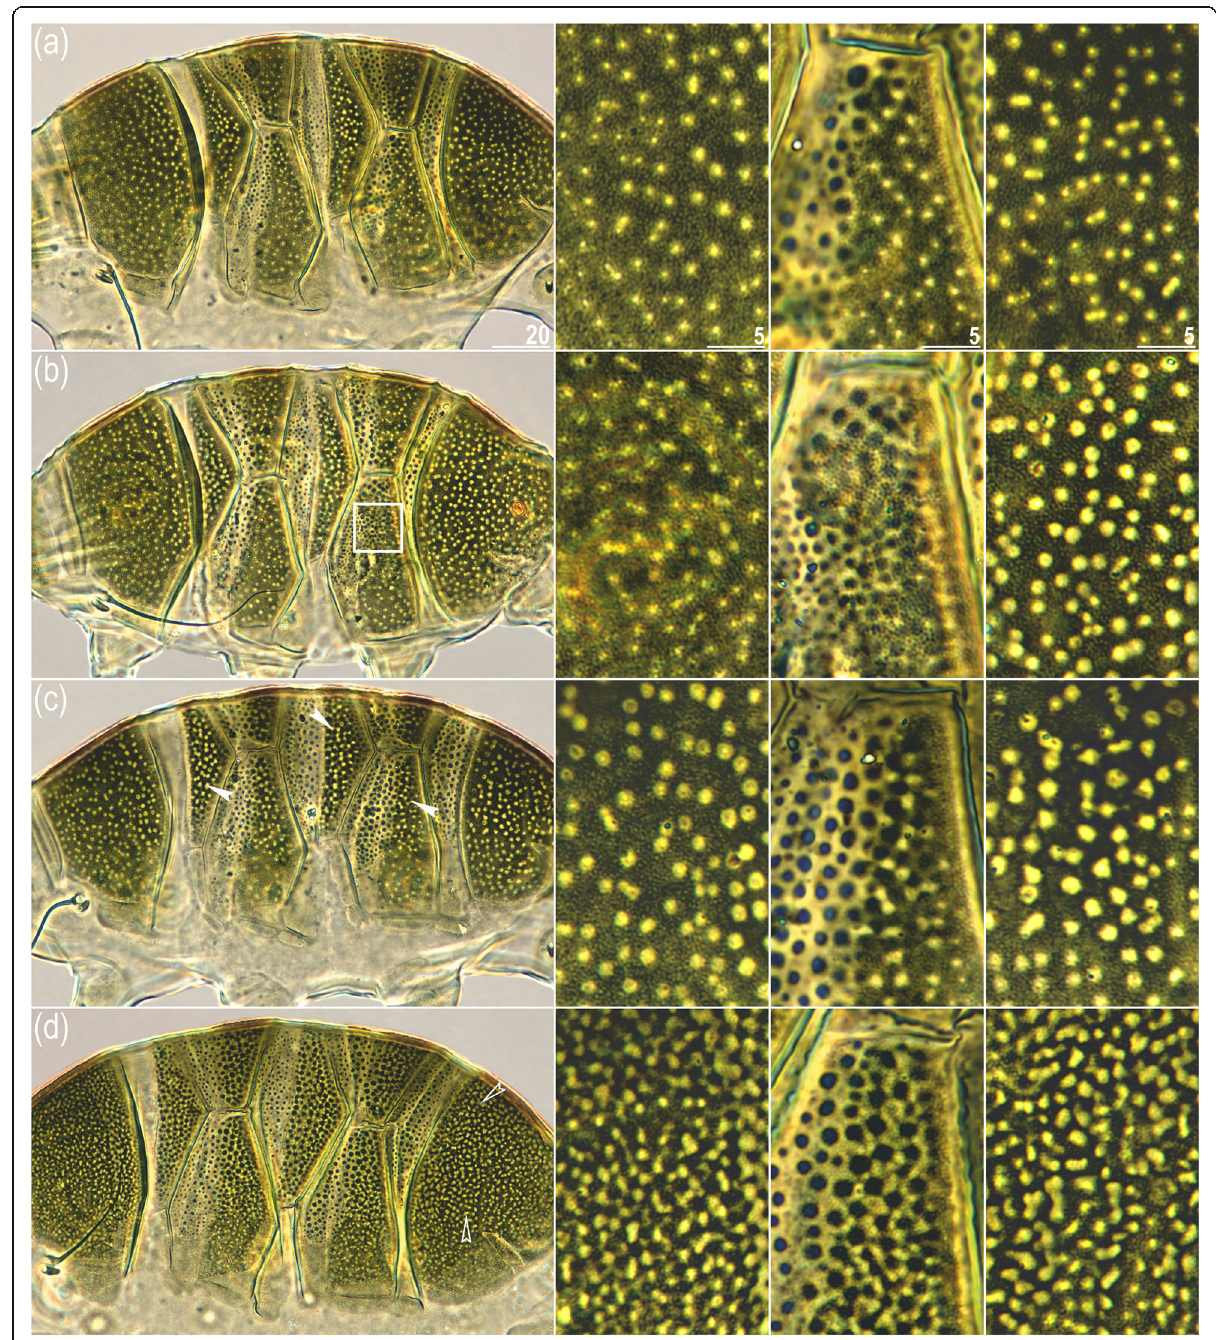
Fig. 2 The variability (morphotypes) of dorsal plate sculpturing in V. viridissimus ; in every row (a – d), the first column shows all dorsal plates, whereas the second, third and fourth columns show close up views of the scapular, second paired, and the caudal plates, respectively: (a) the most common morphotype described in the original description of the species with epicuticular granules present only in the anterior portions of the paired segmental plates, the anterior portion of median plate 2 and on the median plate 3 (the viridissimus morphotype; Indochina), (b) epicuticular granules extend toward the posterior portion of paired segmental plate 2 (indicated by the white frame) (morphotype intermediate between the viridissimus and miraviridis morphotypes; North America), (c) compared to morphotype “ a ” , epicuticular granules present on both median and paired segmental plates (indicated by filled arrowheads; intermediate morphotype; North America), (d) epicuticular granules dominate the dorsal armor, and 2 – 4 neighboring pores merge into large irregular pores, especially on the caudal plate (indicated by empty arrowheads; miraviridis morphotype/ V. miraviridis syn. nov. ; North America). PCM photomicrographs; scale bars in μ m, scale in all columns the same as indicated in the first